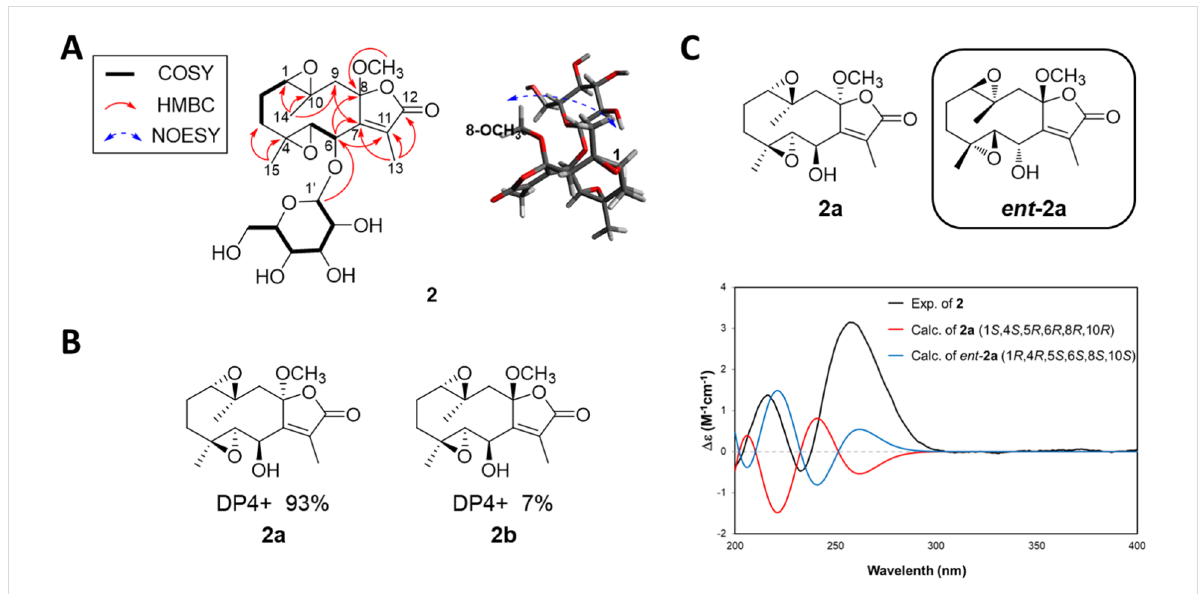
Figure 3: Structure elucidation of 2 . (A) Key COSY, HMBC, and NOE correlations of 2 . (B) DP4+ analysis results for 2a and 2b . (C) Comparison of calculated ECD data of 2a with UV corrections and experimental ECD spectrum of 2 .